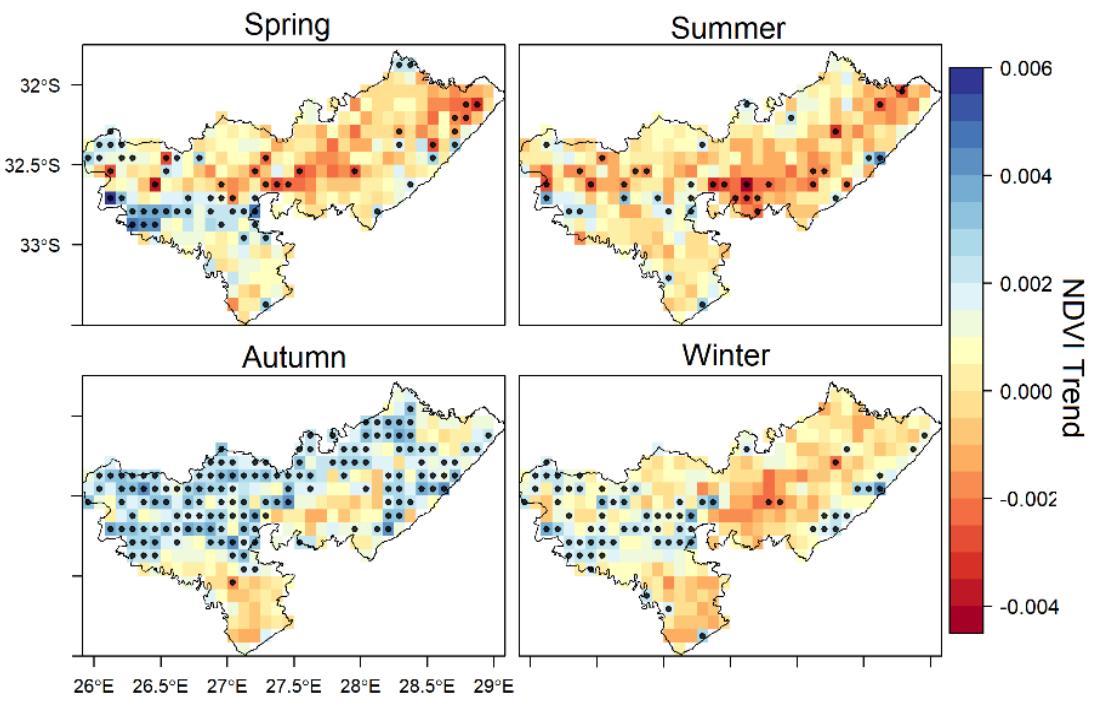
Figure 3. Spatial trends in the NDVI3g across the seasons for Amathole District Municipality. The stippling indicates pixels with statistical significance ( p -value < 0.05).